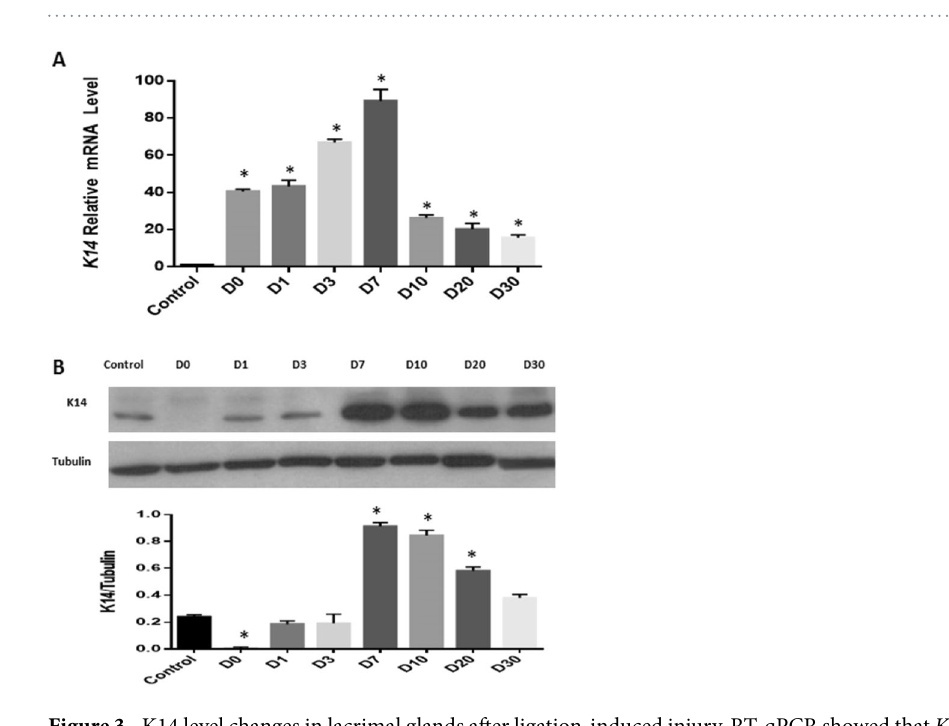
Figure 2. K14 and ∆ Np63 double staining of lacrimal glands after ligation-induced injury. Immunofluorescence staining of K14 (green) and ∆ Np63 (red) on control lacrimal gland ( A ), and samples 0 ( B ), 1 ( C ), 3 ( D ), 7 ( E ), 10 ( F ), 20 ( G ) and 30 ( H ) days post-reopening of the main excretory duct. K14 expression pattern ( A – H ) and level ( I ) changed after ligation-induced injury. ∆ Np63 positive cell number ( J ) is significantly higher in D0 to D20 samples. Blue is DAPI staining. D = Day. * P < 0.05. Bar represents 100 μ m.